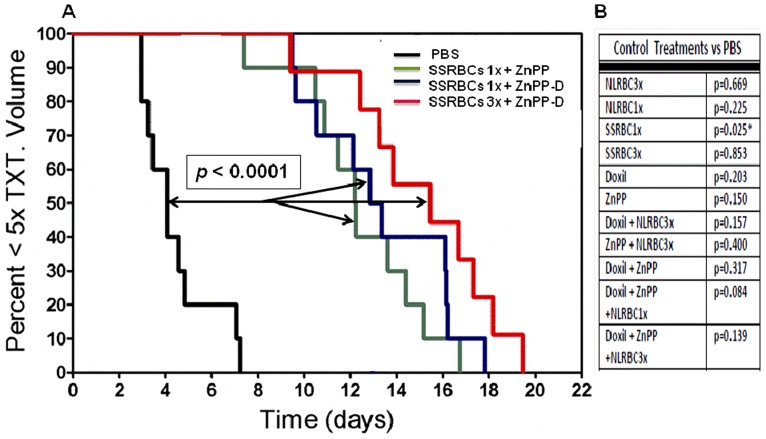
SSRBCs but not NLRBCs combined with prooxidants ZnPP and ZnPP-D induce a tumoricidal response in 4T1 bearing mice.The fraction of mice with tumors <5× the pretreatment volumes versus time is shown (n = 10 for each treatment group). All three groups treated with SSRBCs combined with ZnPP or ZnPP-D show significant tumor growth delay compared to PBS controls. In the adjacent Table, a control experiment shows that tumor bearing animals receiving SSRBCs 1× or 3× alone, NLRBC 1× or 3× alone, NLRBCs 1× or 3× with ZnPP or ZnPP-D, ZnPP alone or Doxil + ZnPP exhibited no significant tumor growth delay versus the PBS control. * indicates that mice receiving SSRBC1× alone displayed significantly accelerated tumor growth compared to the PBS control.